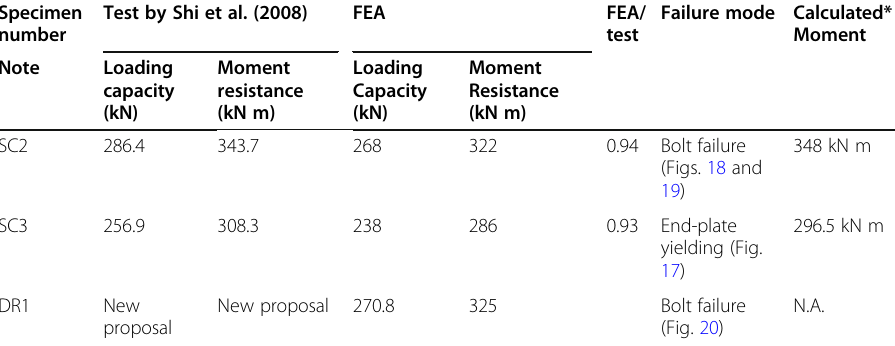
Table 3 Comparison of loading capacities between FEA and tests Specimen number